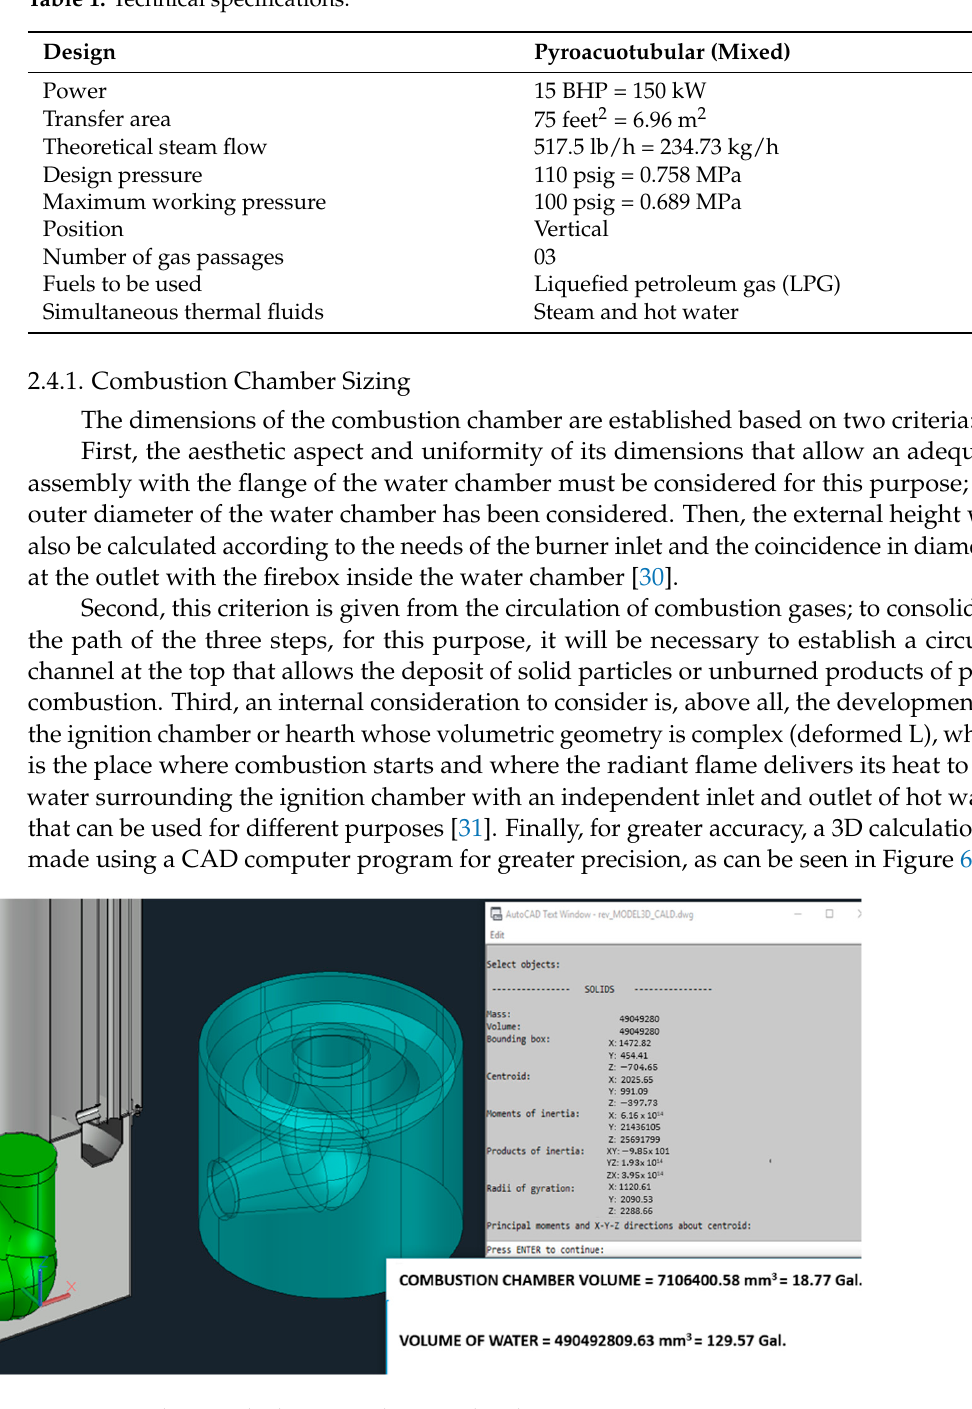
Table 1. Technical specifications.